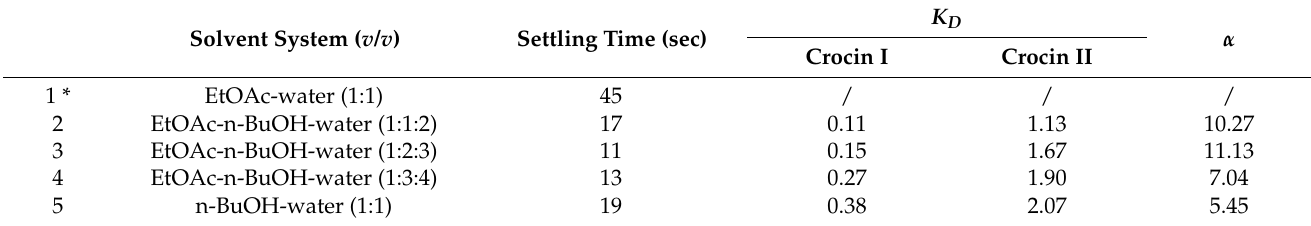
Table 2. Partition coefficient ( K D ) for target components and solvent settling time in several solvent systems.